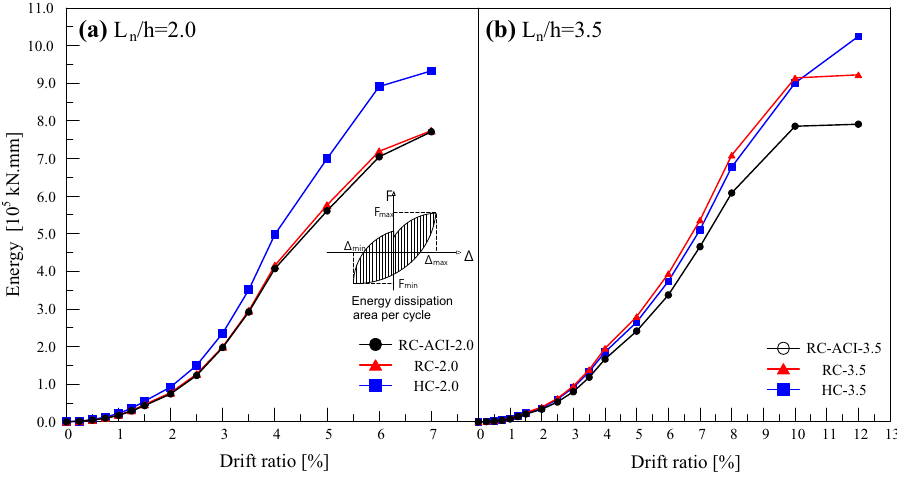
Fig. 13 Cumulative energy